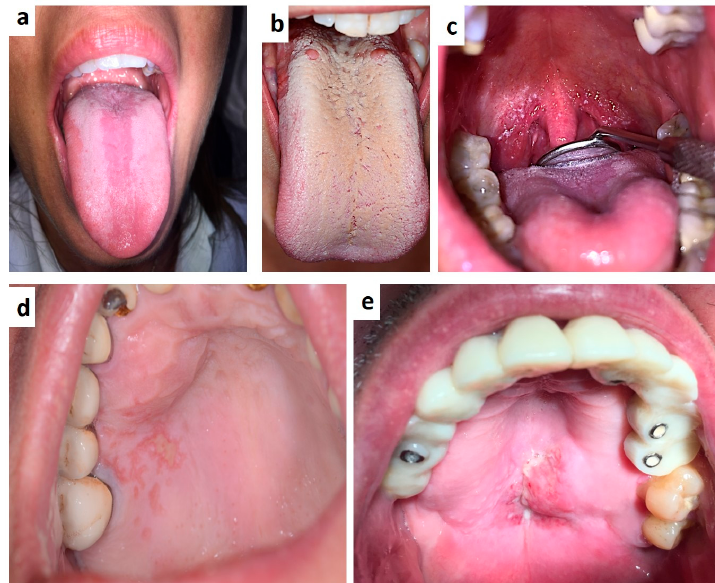
Figure 2. ( a – e ) Oral candidiasis of the median tongue ( a ), diffuse ( b ) or oro-pharingeal are frequent the first sign of HIV infection in unaware patients, as well Herpetic lesion of long-lasting duration occurring in un-conventional site, like the palate ( c ). Non-Hodgkin’s lymphoma of the palate in an already diagnosed HIV-patient.